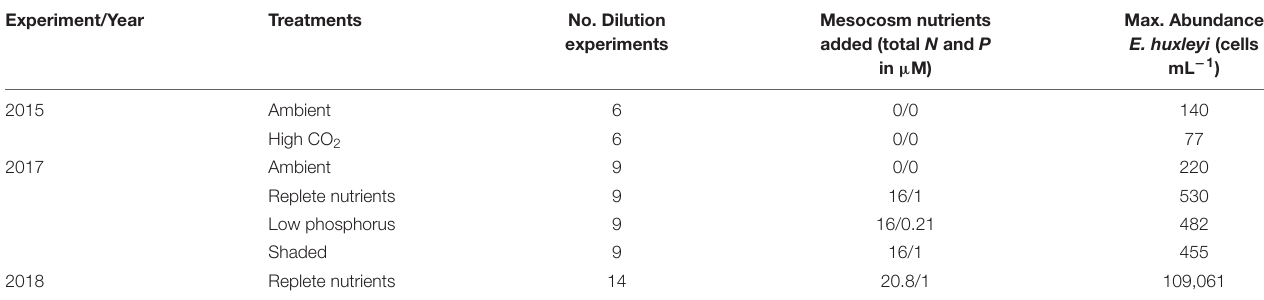
TABLE 1 | Description of experimental treatments, number of dilution experiments, mesocosm nutrient additions and the maximum observed abundance of E. huxleyi within mesocosm experiments in 2015, 2017, and 2018. Experiment/Year